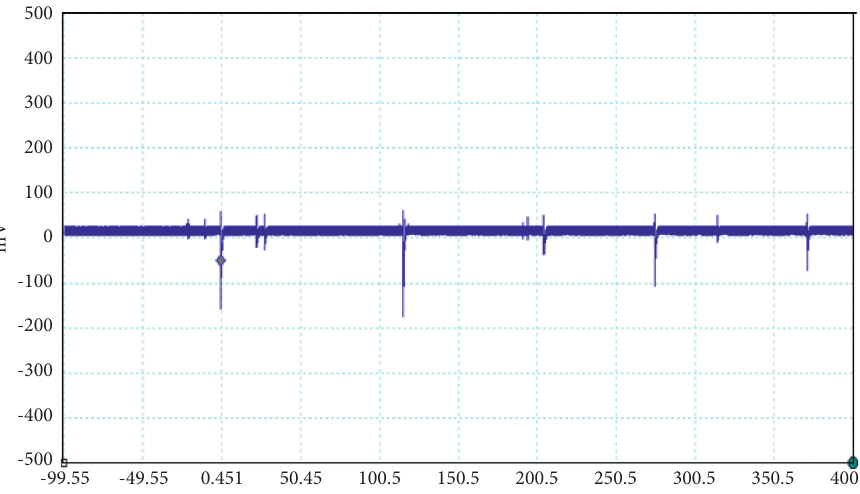
Figure 7: Example of the unusual lightning signal of window size 500ms, which is recorded as a flash number 20150610-0001 in Kathmandu, Nepal.